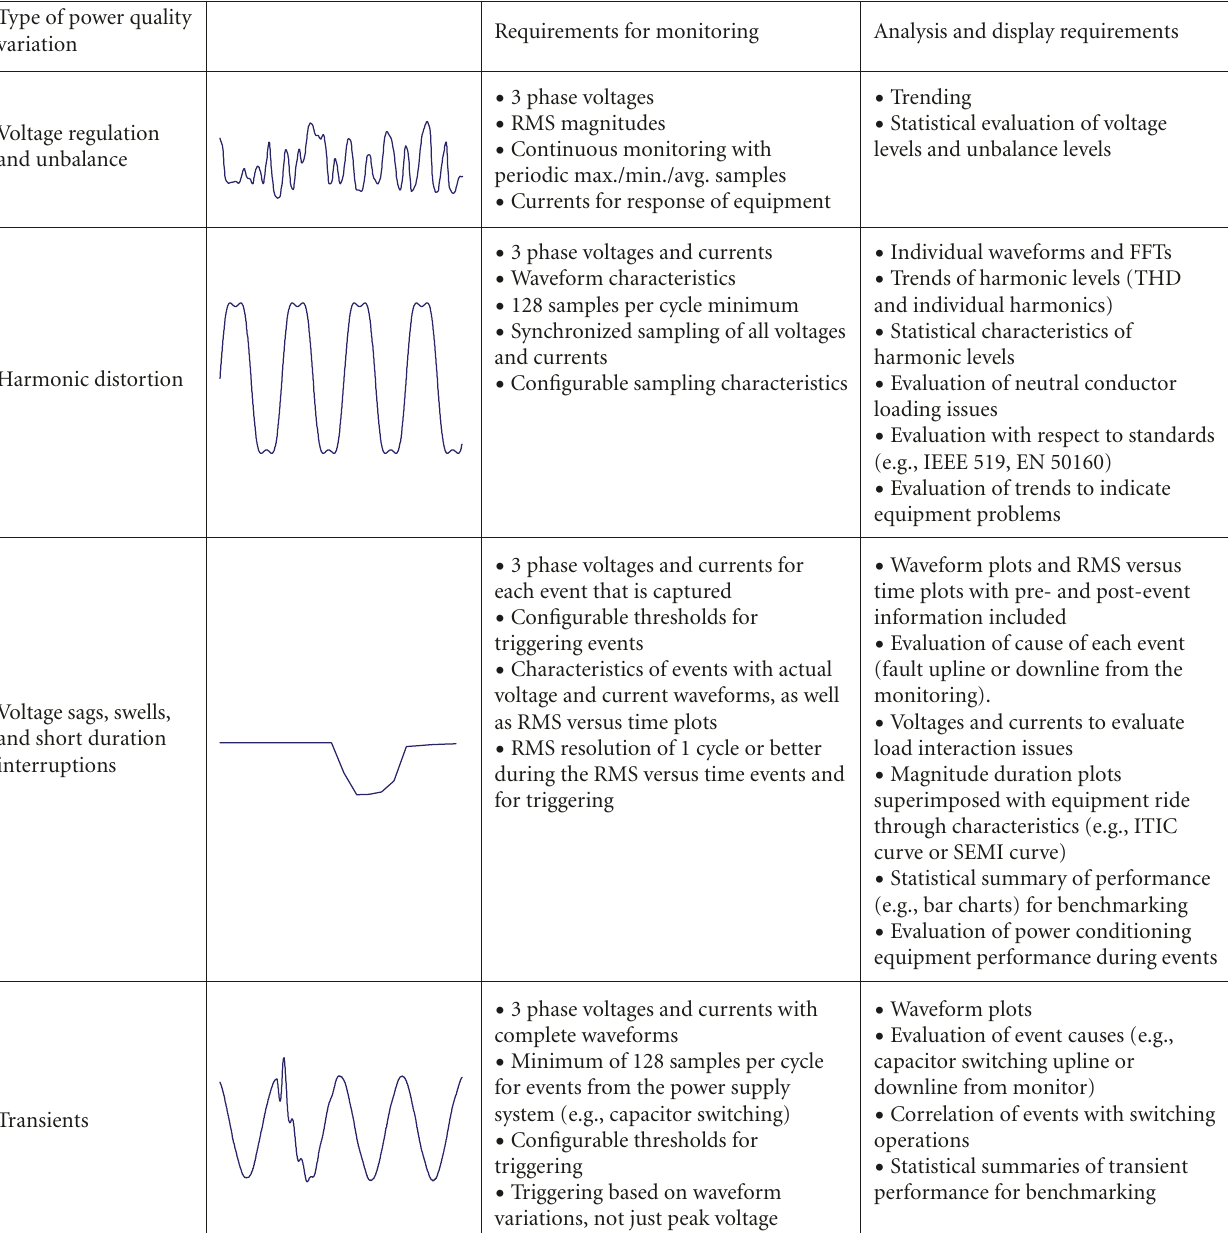
Table 1: Summary of monitoring requirements for di ff erent types of power quality